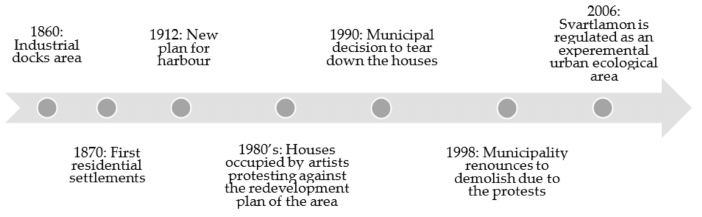
Figure 3. Timeline of Svartlamon’s history (by the